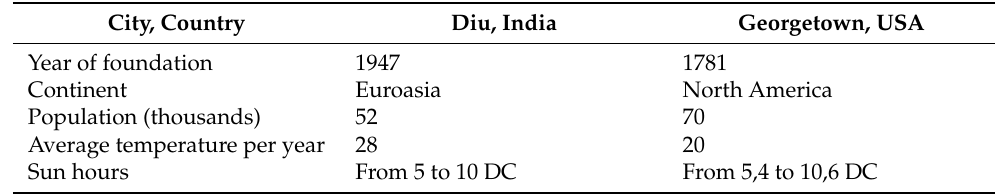
Table 1. Comparison table for Diu and Georgetown. City, Country Year of foundation Continent Population (thousands) Average temperature per year 28 Sun hours From 5 to 10 DC From 5,4 to 10,6